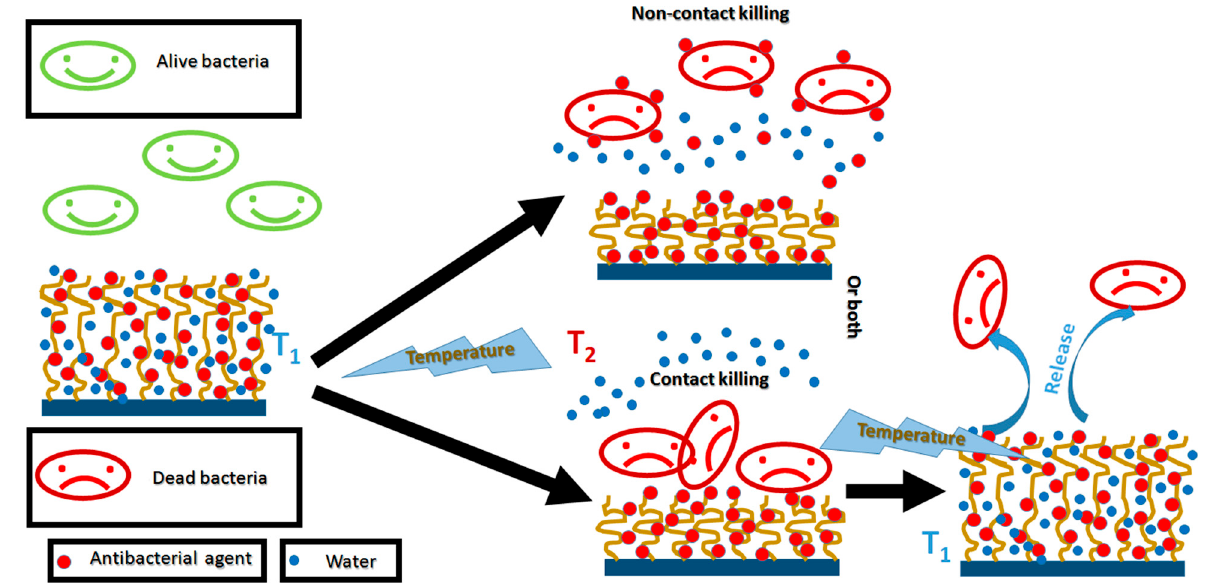
Figure 9. Controllable bacterial kill–release strategy based on TRPBCs.